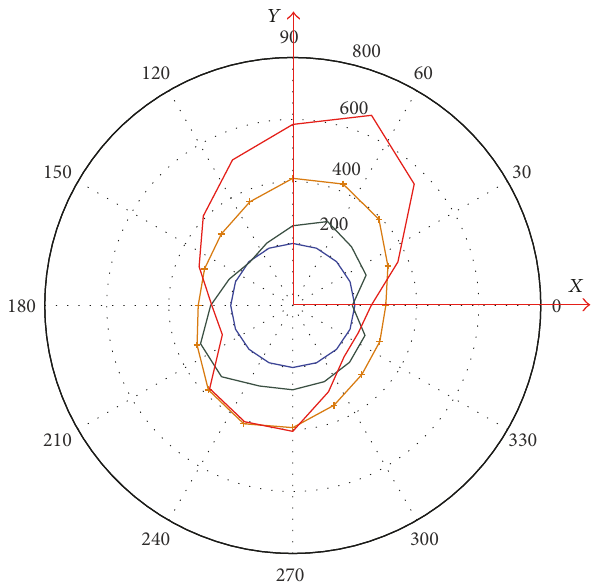
Figure 4: Pads clearances distribution ( 𝜇 m) in the upper journal bearing of an LHG: (a) nominal: clearance condition A, blue circle; (b) measured at 0 MW: condition B, closed curve in green; (c) simulated at 700 MW: condition C, crossed ellipse in orange; (d) measured at 700 MW: condition D, outer closed curve in